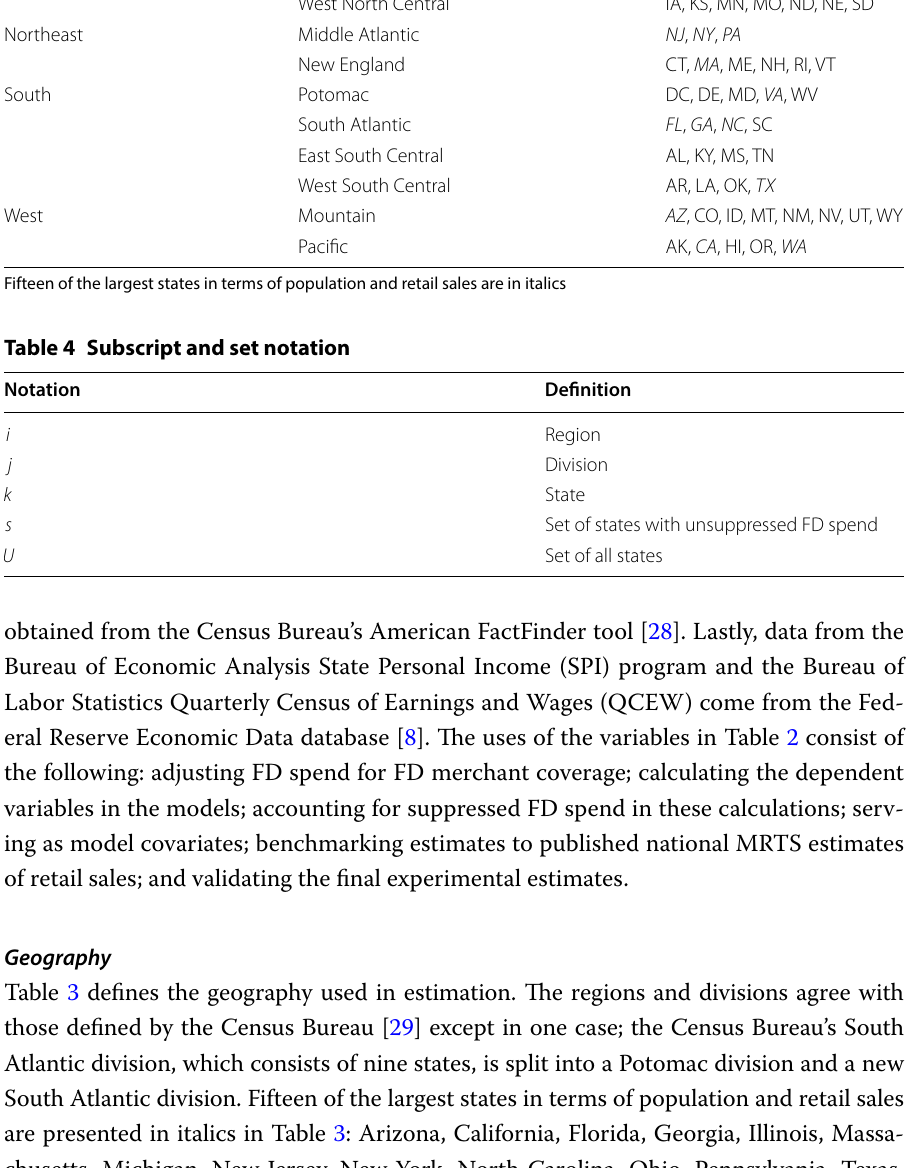
Table 3 defines the geography used in estimation. The regions and divisions agree with those defined by the Census Bureau [29] except in one case; the Census Bureau’s South Atlantic division, which consists of nine states, is split into a Potomac division and a new South Atlantic division. Fifteen of the largest states in terms of population and retail sales are presented in italics in Table 3: Arizona, California, Florida, Georgia, Illinois, Massa-